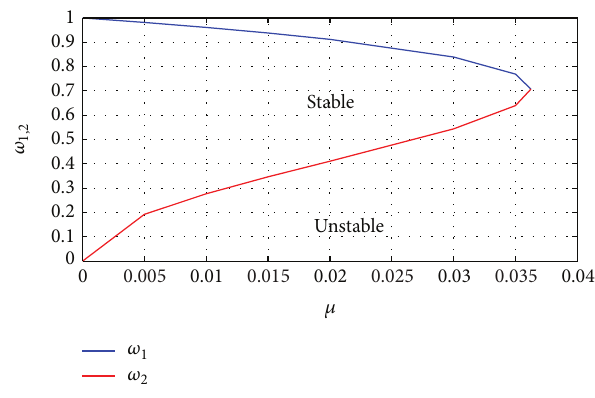
, 𝑞 ) 1 2 1 11 + 2𝐴 18𝐴 2